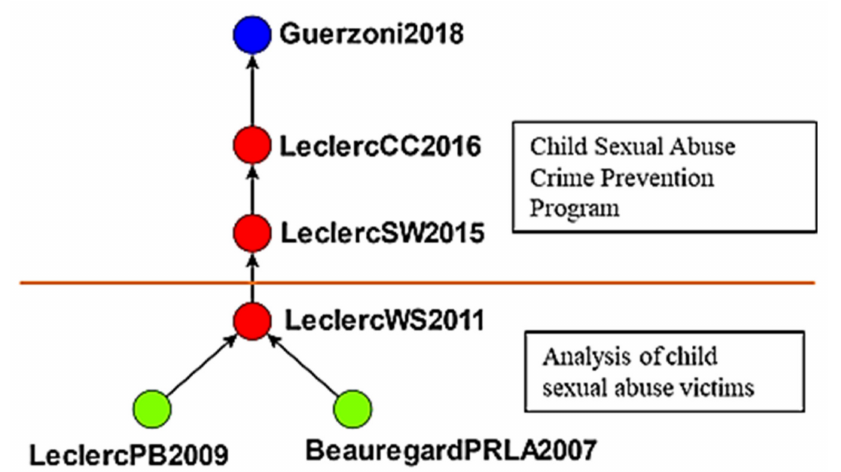
Figure 10. Global main path analysis of fifth cluster (Top to bottom). Strategies for preventing childhood sexual abuse; analysis of childhood sexual